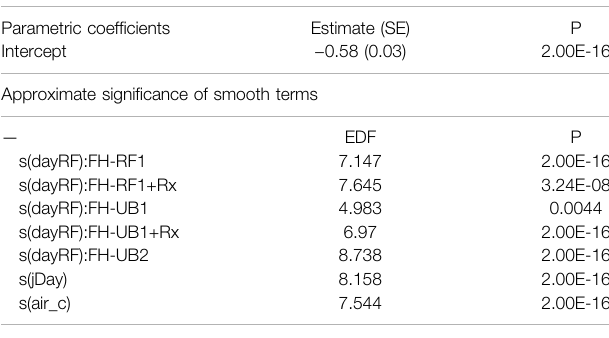
TABLE 2 | Summary of best performing generalized additive mixed model (GAMM) assessing the relationship of Acoustic Complexity Index (ACI) to fi re history, seasonality, and weather (regional temperature and rain). SE = standard error; dayRF = days since Rough Fire extinguished; jDay = Julian day; air_c = air temperature; FH = fi re history category ( Table 1 ); site = monitoring site number; REML = restricted maximum likelihood smoothing parameter. Model formula